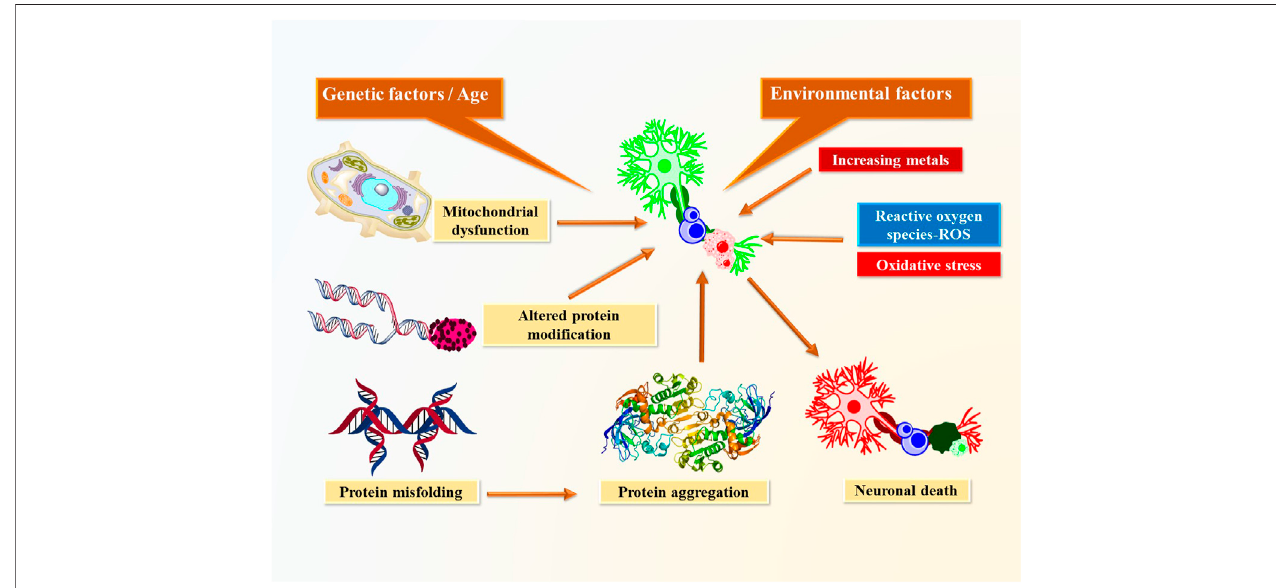
FIGURE 1 | Mechanism involve in development of neurodegenerative